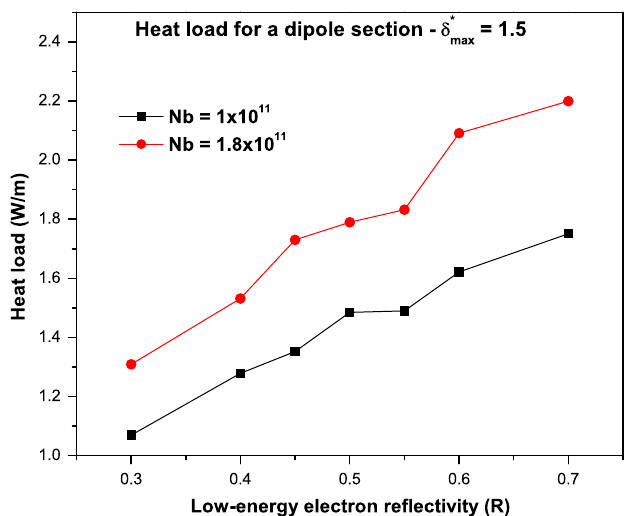
FIG. 17. Simulated heat load for a dipole section as a function of the initial number of macroparticles per bunch for two differ- ent bunch intensities and (cid:1) (cid:3) max ¼ 1 : 5